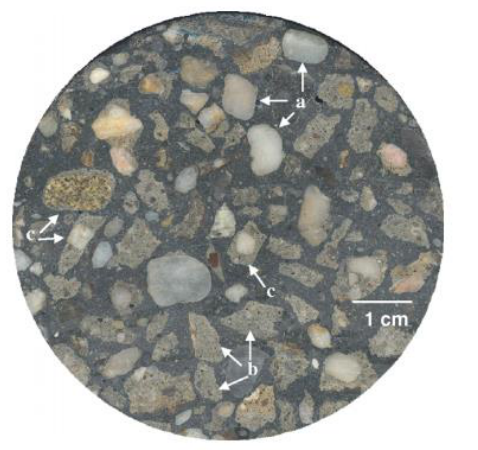
Figure 4. Cross-section of concrete with 6.35-12.7 mm recycled concrete aggregate showing examples of : (a) clean stone ; (b) mortar ; and (c) stone with surronding